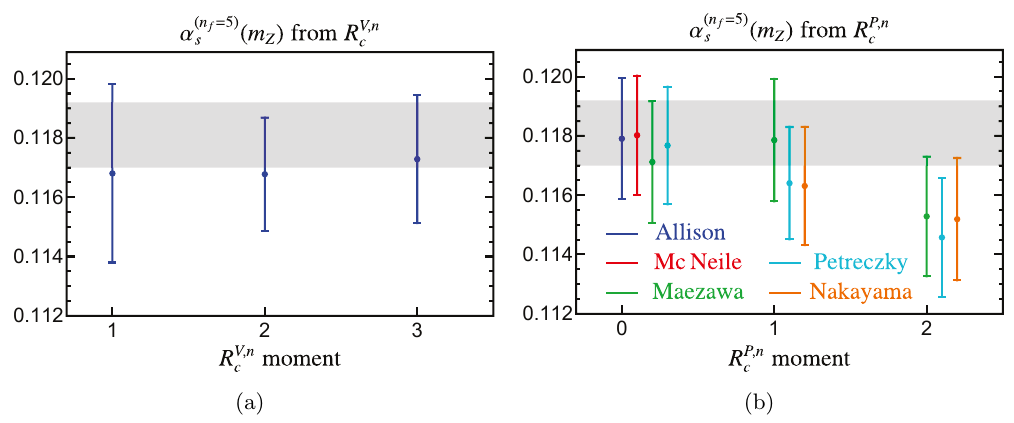
Figure 4 . (cid:11) ( n f =5) s ( m Z ) determination from ratios of charm vector-correlator (left panel) and pseudo-scalar (right panel) moments. Error bands include all sources of uncertainties added in quadrature. Panel (a) has results for the (cid:12)rst three ratios of moments. Panel (b) has results in di(cid:11)erent colors for lattice output from various collaborations: from left to right these are Allison et al. [8], McNeile et al. [9], Maezawa et al. [10], Petreczky et al. [11], and Nakayama et al. [12]. n = 0 corresponds to R P; 0 (cid:17) M P; 0 , while n = 1 ; 2 stand for R P;n . Perturbative uncertainties are c c c estimated trimming the grids with the default parameter (cid:24) = 2. The light gray area shows the current (2019) world average with its uncertainty